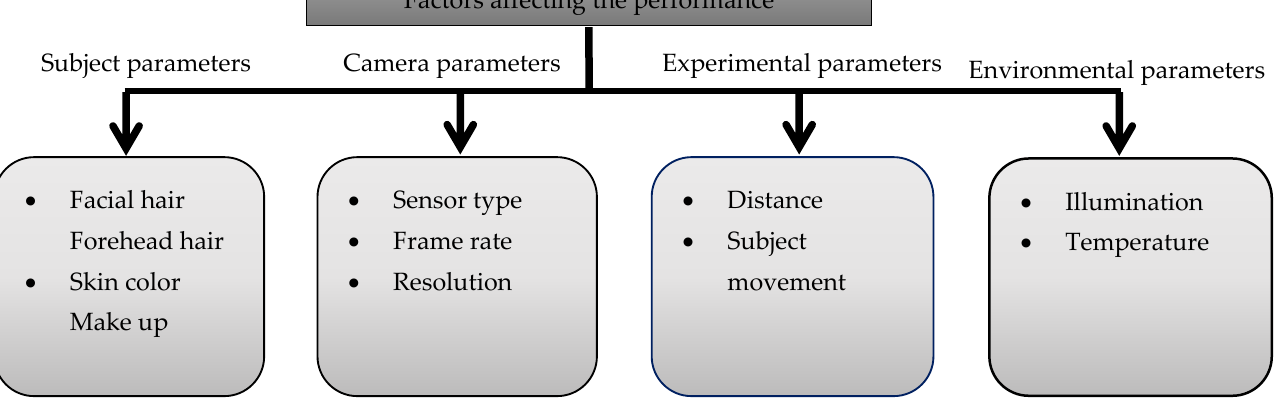
Figure 11. Factors affecting the vital signs performance.